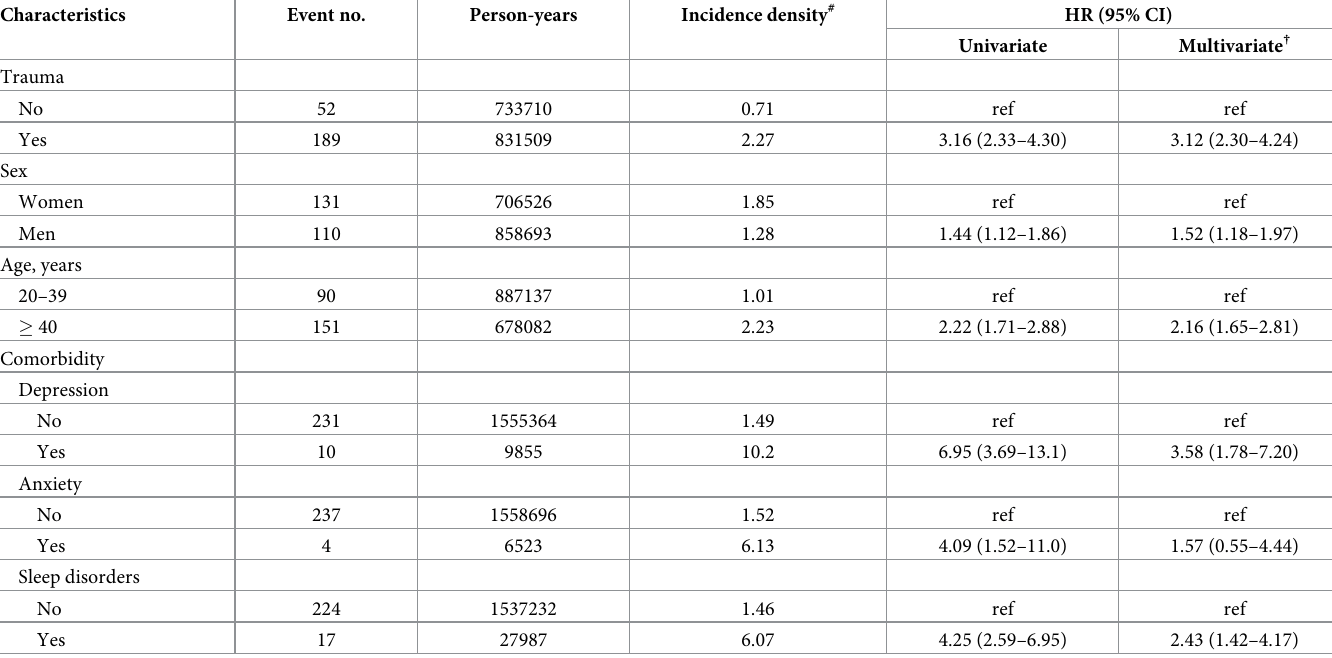
Table 2. Cox model measured hazard ratios and 95% confidence interval of dystonia associated with trauma and covariates. Characteristics